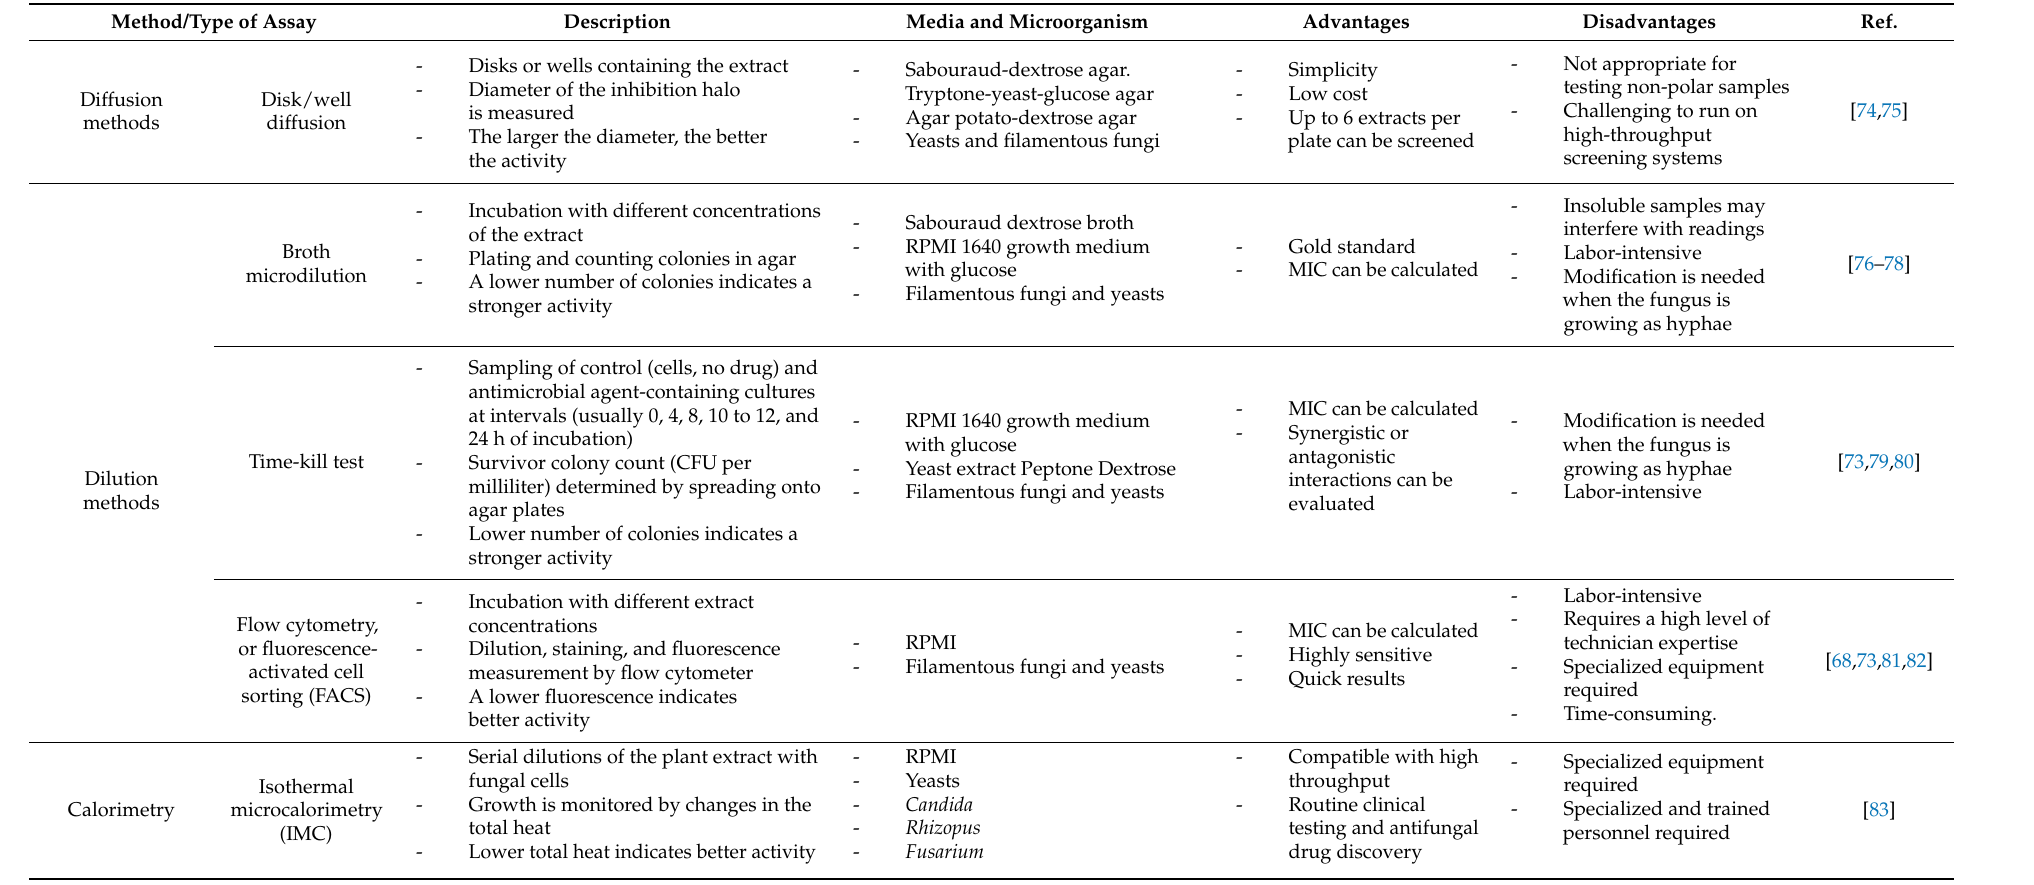
Table 1. Methods to assess antifungal